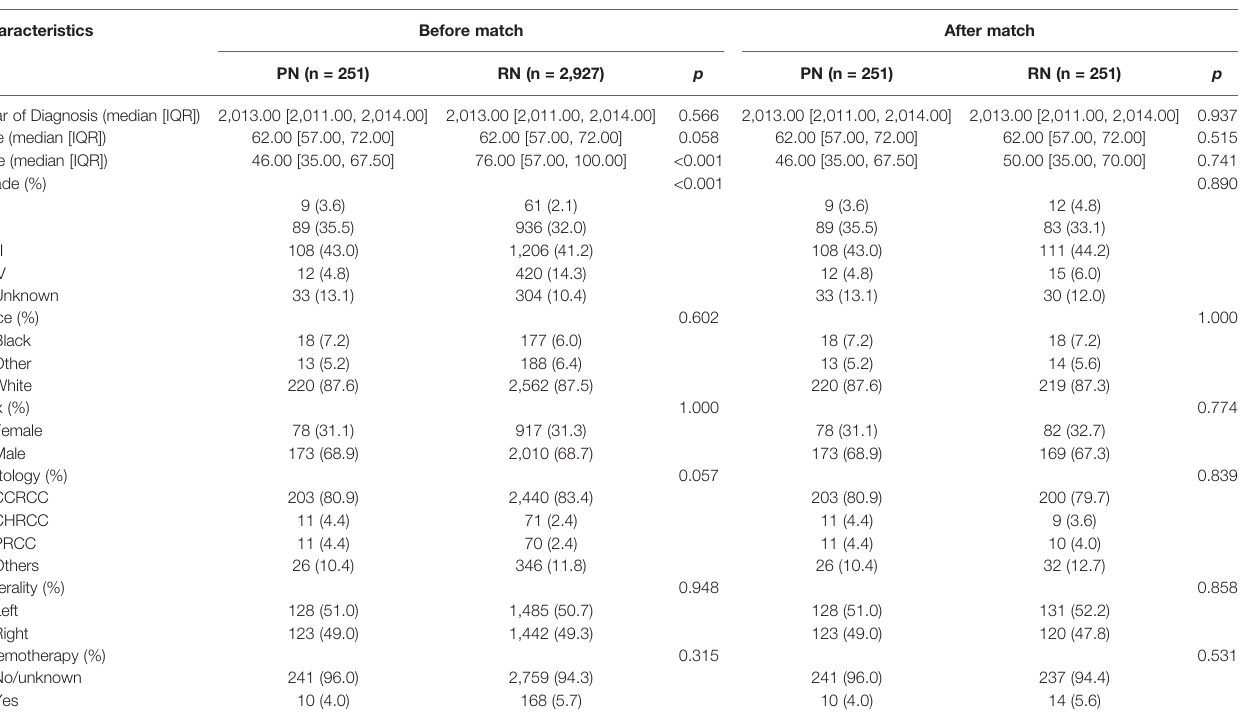
TABLE 3 | Characteristics of venous invasion cohort before and after PSM. Characteristics Before